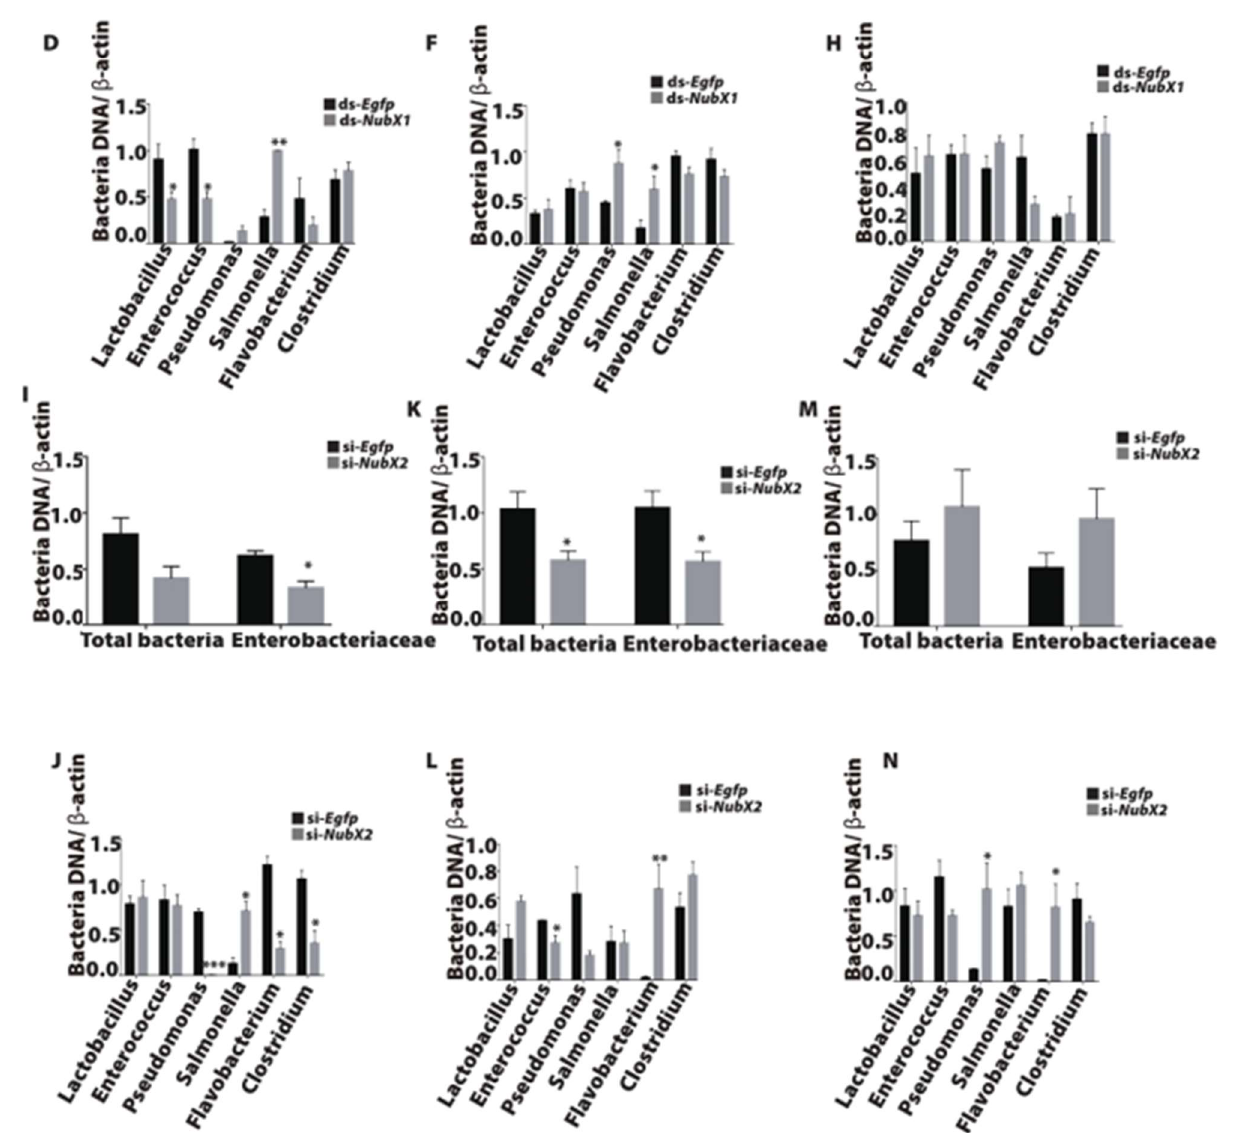
Figure 5. Effect of BdNubX1 and BdNubX2 RNAi on gut microbiota. ( A , B ) BdNubX1 and BdNubX2 expression levels after dsRNA and siRNA injection, respectively. ( C ) The gut total bacteria and Enterobacteriaceae abundance at 3d in BdNubX1 RNAi flies. ( D ) The different genus bacteria abundance at 3 d in BdNubX1 RNAi flies. ( E ) The gut total bacteria and Enterobacteriaceae abundance at 5d in BdNubX1 RNAi flies. ( F ) The different genus bacteria abundance at 5 d in BdNubX1 RNAi